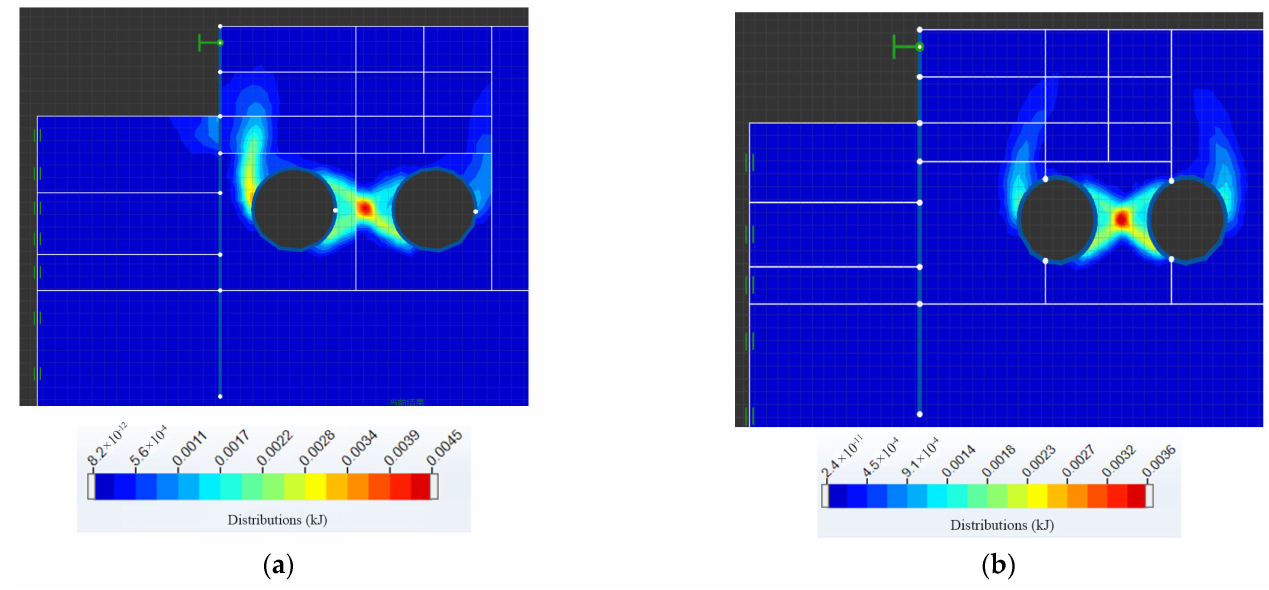
Figure 13. Shear dissipation contours under different horizontal distance L in stage (2): ( a ) L = 0.33 H and ( b ) L = 0.5 H.